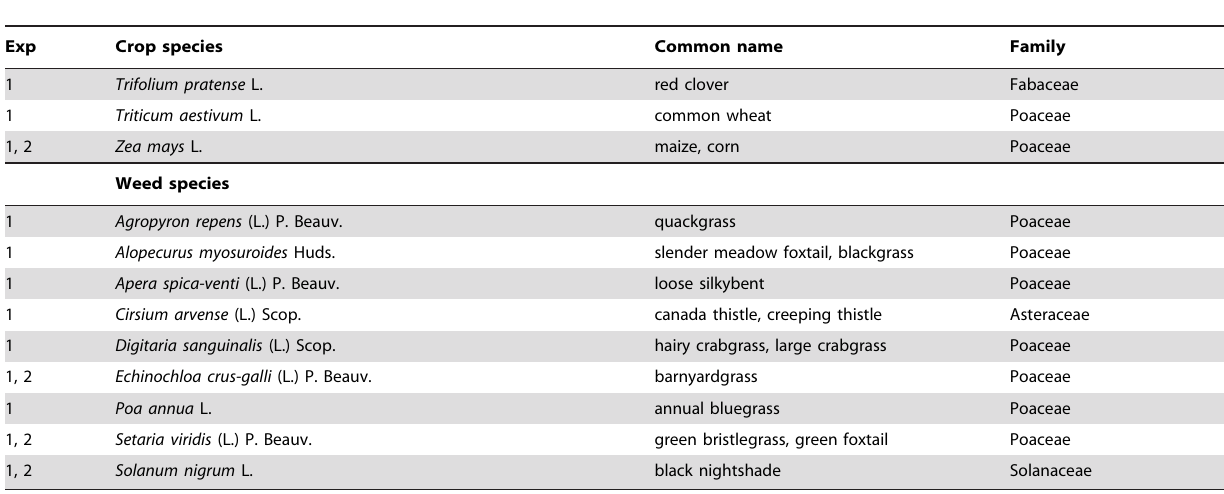
Table 1. Plant species used in experiments 1 and 2 with the respective common name and